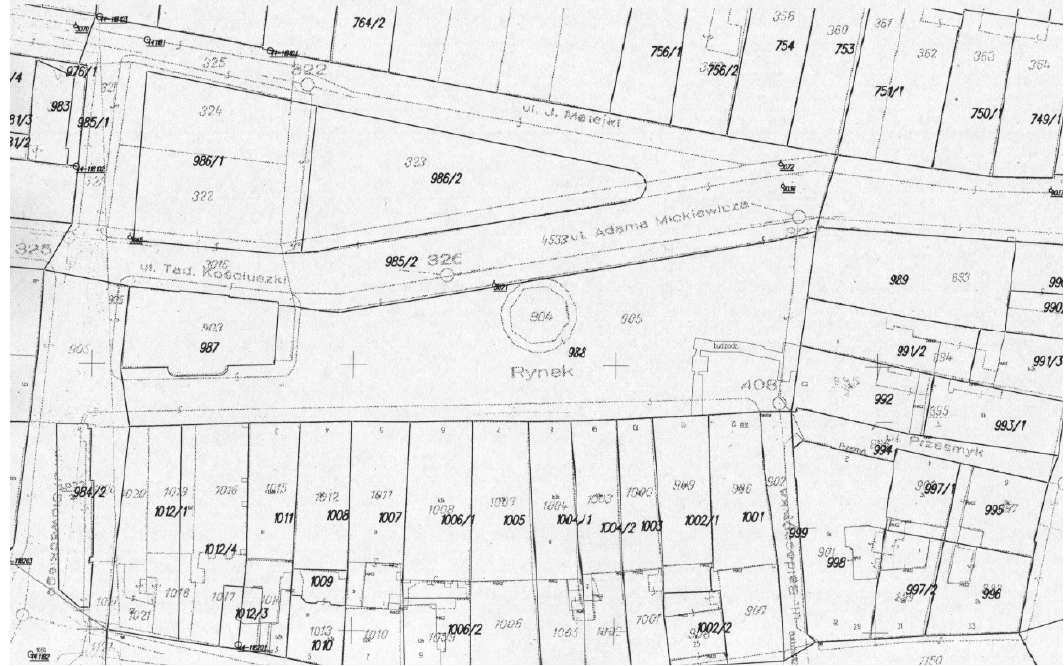
Figure 6. Comparison of the contents of the Austrian cadastral map with the present cadastral map. Source: own study.